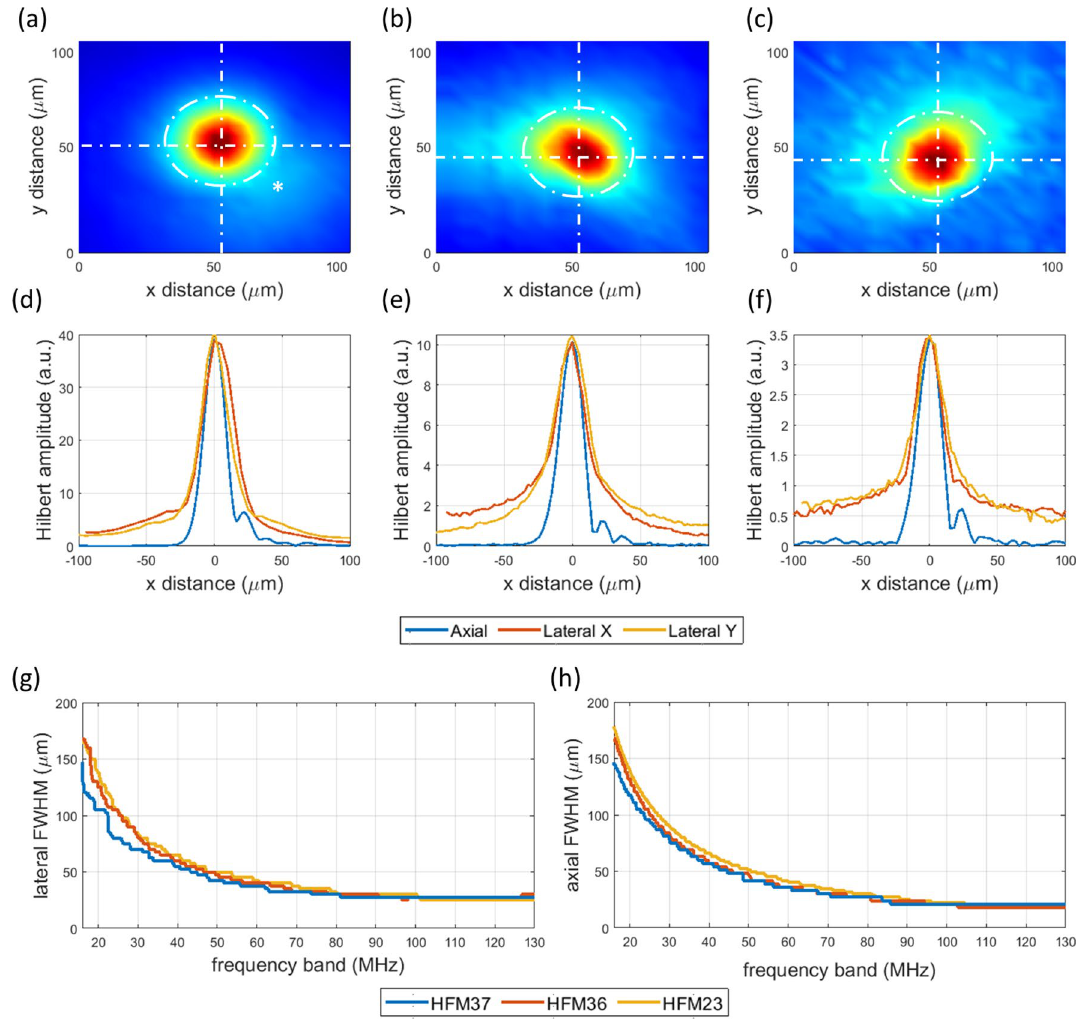
Figure 2. ( a – c ) Normalized Optoacoustic transducer sensitivity maps at XY focal planes of ( a ) HFM23 spherical transducer (no hole) ( b ) HFM36 spherical transducer with aperture ( c ) HFM37 axicon transducer with central aperture. ( d – f ) Axial and lateral Hilbert resolutions of each transducer respectively. ( g , h ) Lateral and axial resolutions as a function of transducer frequency band for all three detectors manufacturing. The lateral and axial spatial resolutions obtained for each transducer are shown in Fig. 2d–f. All three detectors yield full-bandwidth resolutions of approximately 28 μm and 18 μm, for the lateral and axial, respectively. Such a similar performance is attributed to their comparable sensitivity bandwidth. By virtue of the ultra-broad band sensitivity featured in these detectors, we further explored the dependency on acoustic band- width on the specific lateral resolution of each detector, as shown in Fig. 2g. An exponential relationship between resolution and frequency band was found starting from 15 MHz. The resolution limit was only obtained at full bandwidth, despite frequencies above 85 MHz having a reduced contribution to lateral resolution performance for the characteristic signal sensitivities of these transducers. This was also observed for the axial resolution, as depicted in Fig. 2h. Figure 3 shows the sensitivity maps for each transducer along the (lateral) X and (axial) Z directions. In particular, the XZ sensitivity maps for the spherical detectors (HFM23 Fig. 3a, HFM36 Fig. 3b) confirm the focusing nature expected from these geometries, with low frequency lobes being observed in the near field due to the shorter propagation distance. In contrast, the XZ sensitivity map for the axicon detector (HFM37) is characterised by a thin pencil beam over an extended depth as seen in Fig. 3c. The depth of focus for all three transducers are compared in Fig. 3d, yielding 220 μm and 250 μm for the spherical cases (HFM23 and HFM36, respectively), and 1050 μm for the axicon case (HFM37)—4.2 times that of the spherical counterpart with central aperture (HFM36). As illustrated in Fig. 3e, a 40 μm lateral resolution is retained for a 950 μm depth of focus, and remains below 60 μm for a 1050 μm depth of focus. Note that the axicon detector indeed presents an extended depth compared to its spherical counterparts; however, it features lower sensitivity, in particular compared to the equivalent reference spherical detector with central aperture (Fig. 1c,e). The HMF23 measured a depth of focus